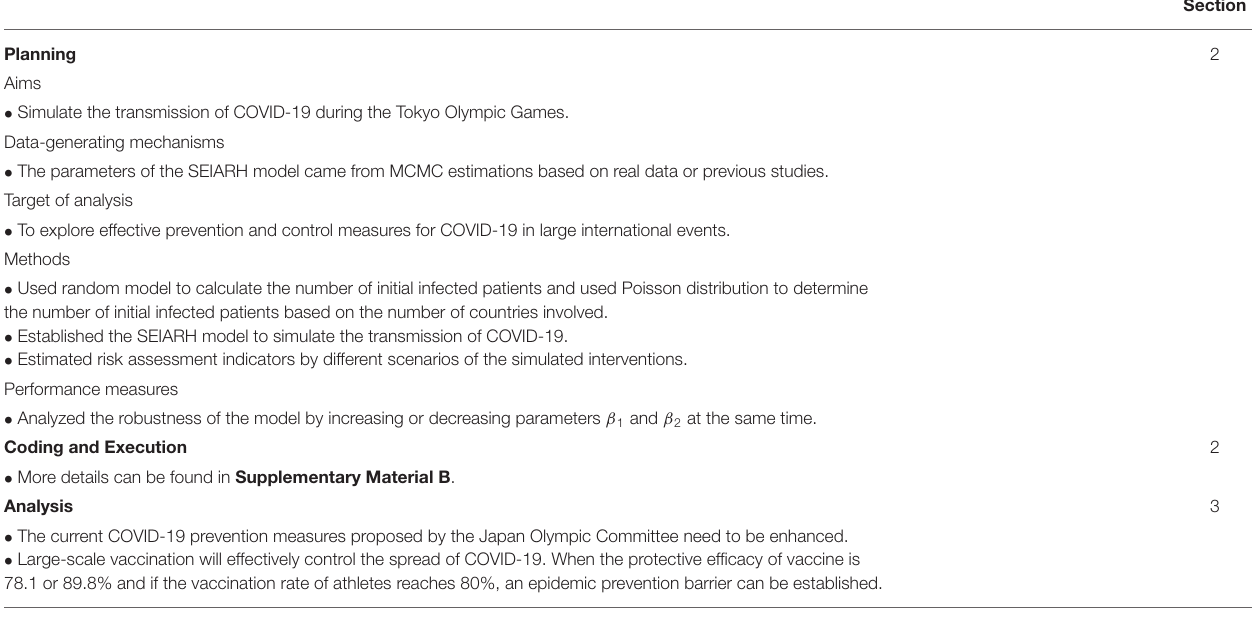
TABLE 2 | Key steps and results in the planning, coding, and analysis of this simulation study.